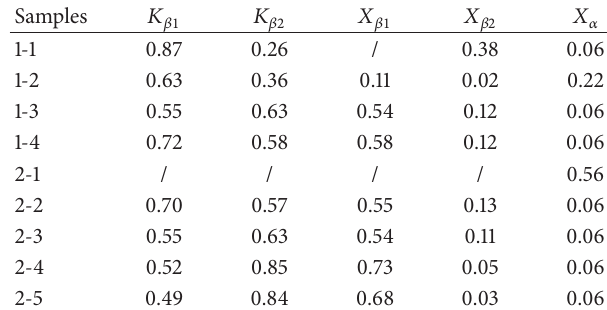
Table 1: The compositions of composites (weight ration). Samples